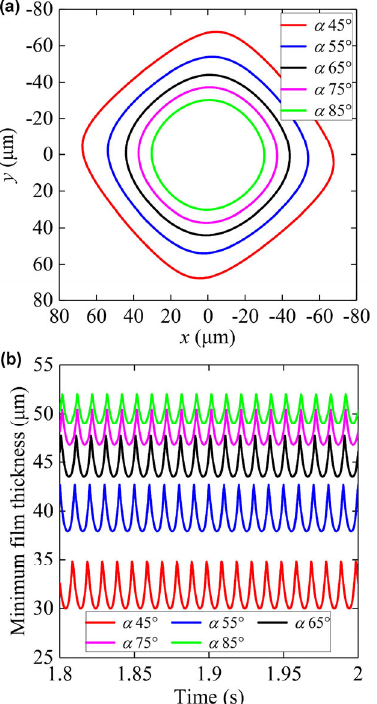
Fig. 14 (a) Journal center orbits and (b) dynamic minimum film thicknesses of a TPJB without static loads for different pad arc